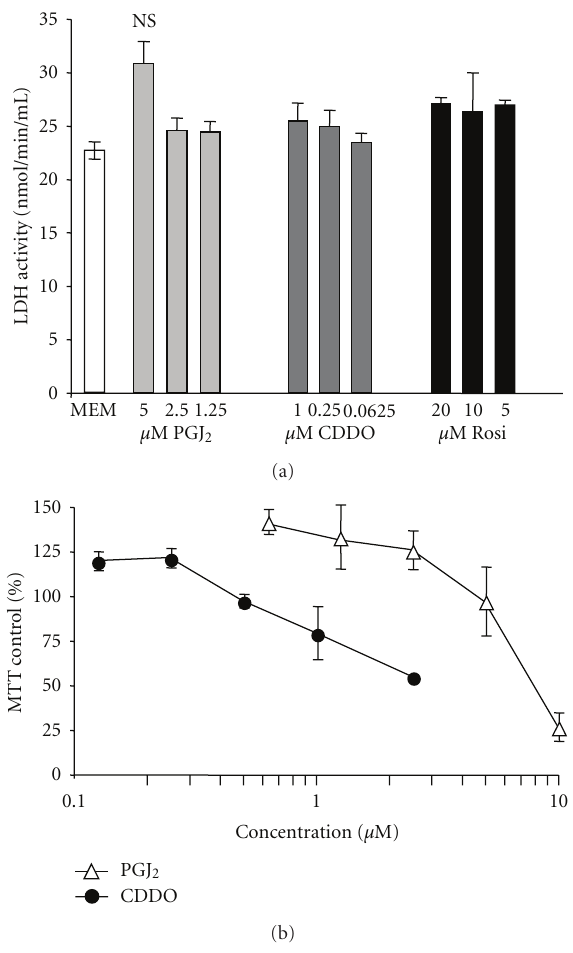
Figure 2: The PPAR γ ligands are not overtly cytotoxic at the doses used. (a) Primary human lung fibroblasts were treated for 24 hours with the indicated concentrations of CDDO, or 15d-PGJ 2 (PGJ 2 ), and LDH released into the media was measured by commercial LDH activity assay. There were no significant di ff erences between any of the treatment groups compared to MEM control. Results are mean ± standard deviation for triplicate wells and are representative of 2 independent experiments that yielded similar results. (b) Primary human lung fibroblasts were plated in a 96-well plate and treated with the indicated concentrations of CDDO or 15d- PGJ 2 (PGJ 2 ). Cell viability was determined after 24 hours by MTT assay. The results shown are the mean ± standard deviation of quadruplicate wells and are normalized to untreated control wells.